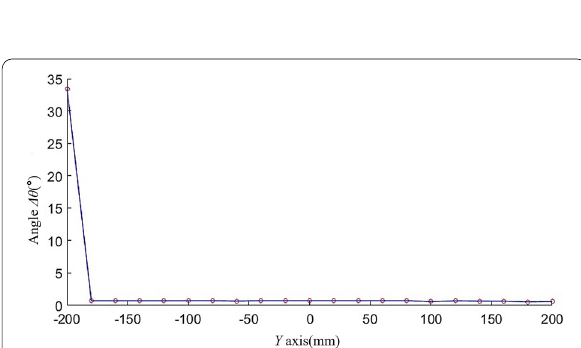
Figure 5 Maximum change of robotic joint angle during bonnet polishing